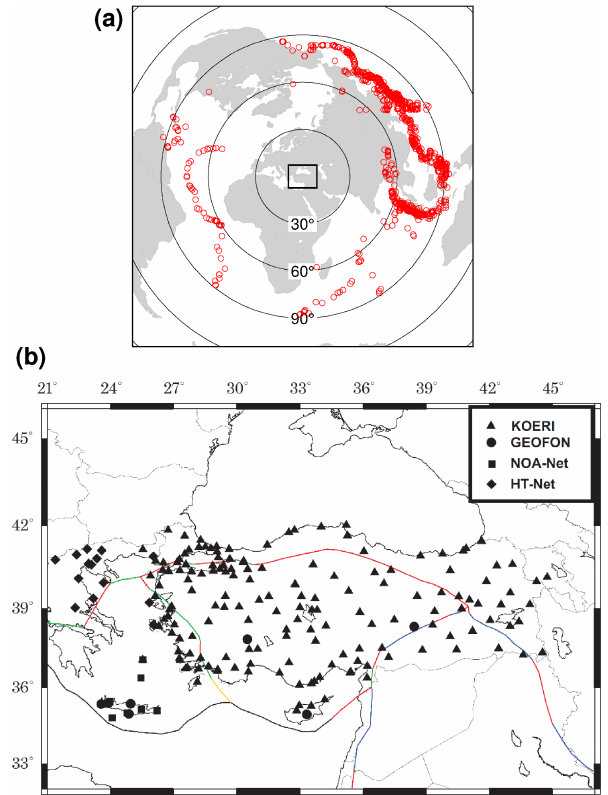
Figure 2. (a) Epicentral distribution of 1028 teleseismic events (M w > 5 . 5) with epicentral distances ranging from 60 to 85 ◦ , marked with red circles. (b) Distribution of 195 analyzed broad- band stations of the KOERI (triangles), GEOFON (circles), NOA- Net (squares) and HT-Net (diamonds)